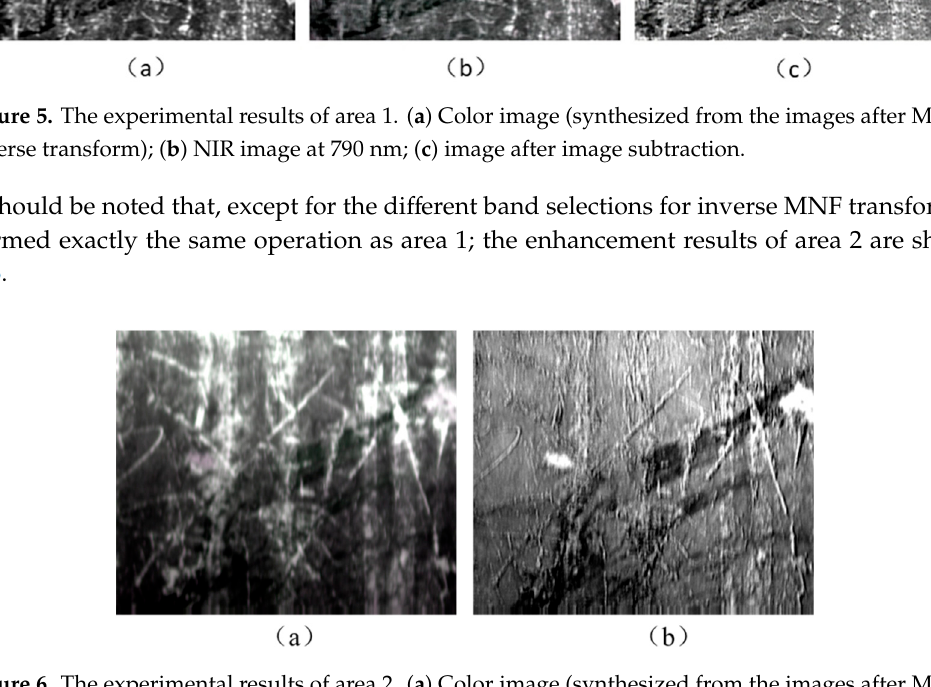
Figure 6. The experimental results of area 2. ( a ) Color image (synthesized from the images after MNF inverse transform); ( b ) image after image subtraction.